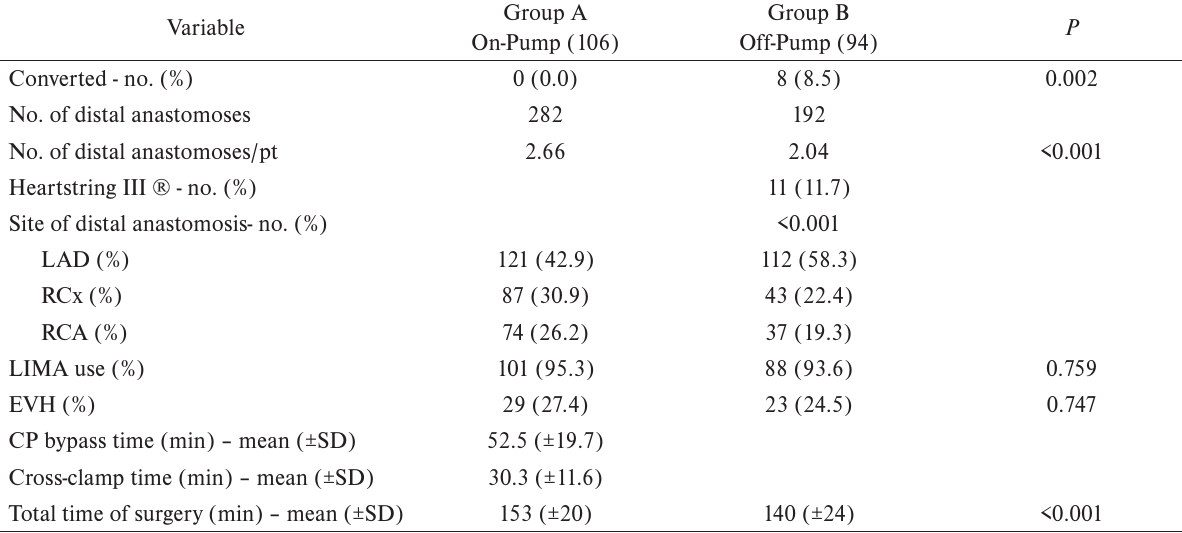
Table 2. Perioperative data (intention-to-treat) * .